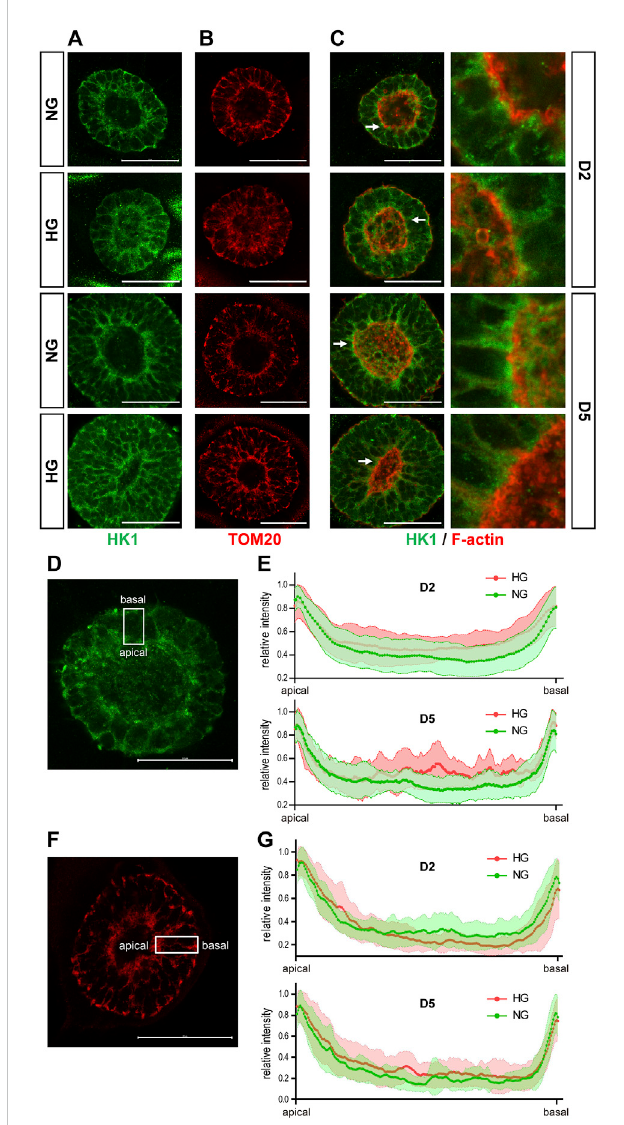
FIGURE 7 High glucose causes HK1 distribution change in the 3D model. (A) Representing images of HK1 (green) in normal (NG) and 2x high glucose (HG) groups at D2 and D5. (B) Representing TOM20 (red) staining at D2 and 5. (C) Double immuno fl uorescence images of HK1 (green) and F-actin (red) at D2 and D5. All scale bar is 50 μ m. (D) Illustration of HK1 distribution. (E) The line pro fi le plots for HK1 distribution relative to the peak intensity at D2 and D5. (N ≥ 9/condition). (F) Illustration of TOM20 distribution. (G) The line pro fi le plots for TOM20 distribution relative to the peak intensity at D2 and D5. N ≥ 6/condition. All scale bar = 50 μ